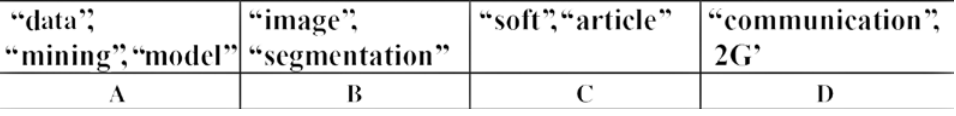
Figure 3: Keywords Extracted from the